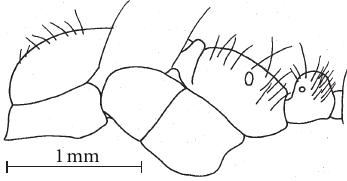
Figure 7: Mesosoma and petiole of a paratype male of C. reburrus .